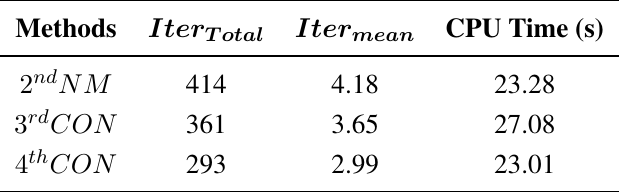
Table 2. Key results for the Chandrasekhar H